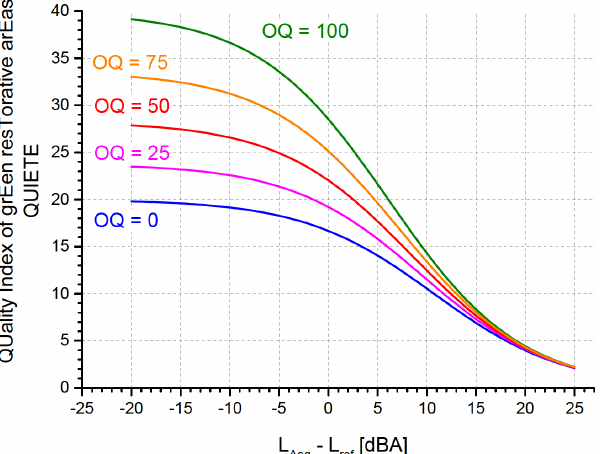
Figure 1: The QUIETE index as function of the difference L Aeq − L ref and some values OQ of the perceived overall quality of the park.